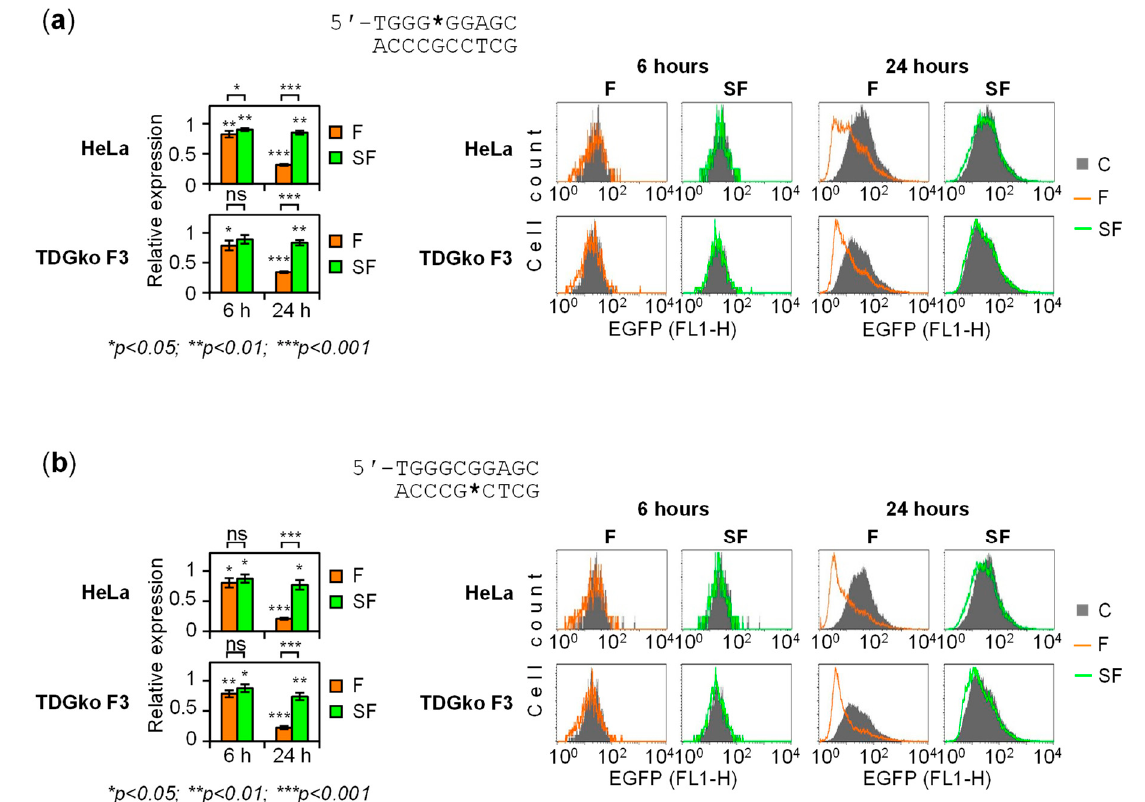
Figure 6. Effect of acytosinic sites on the GC box activity. ( a ) Expression analyses of constructs containing a synthetic abasic site in the purine-rich strand of the GC box. Relative EGFP expression (mean ± SD) for n = 4 independent experiments (left) and the representative fluorescent distribution plots (right). Acytosinic modifications used were tetrahydrofuran (F) or a tetrahydrofuran with nuclease resistant phosphorothioate 5 ′ -linkage (SF). ( b ) Analogous analyses of constructs containing F or SF acytosinic sites in the pyrimidine-rich strand.